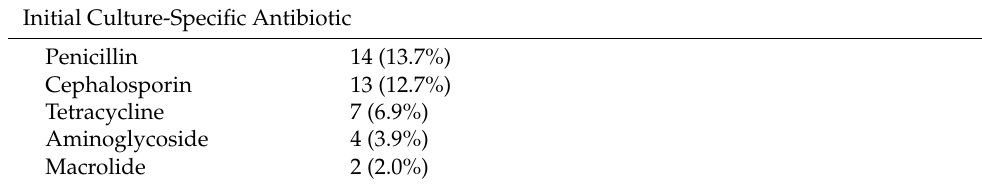
Table 4. Antibiotics and